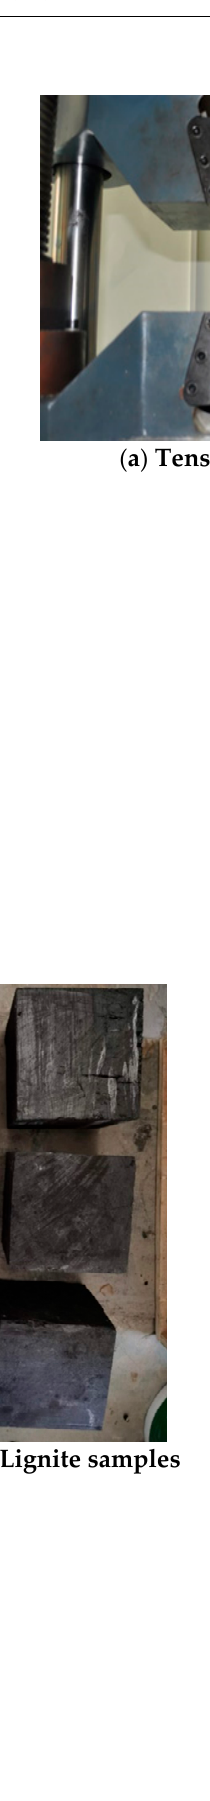
Figure 6. Tensile moulds and samples.